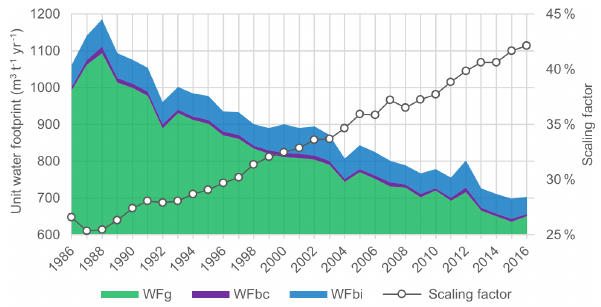
Figure 6. Global trends in average unit water footprints (g – green, bc – blue from capillary rise, bi – blue from irrigation) in cubic metres per tonne per year (m 3 t − 1 yr − 1 ) and yield scaling factors of maize from 1986 to 2016. Note that both y axes do not start at